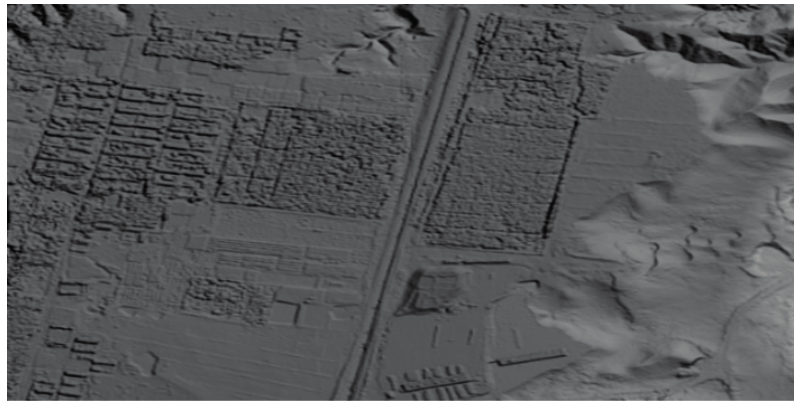
Figure 12. Results of the stitching: ( a , b ) image captured from TSCs and ( c ) stitched image.